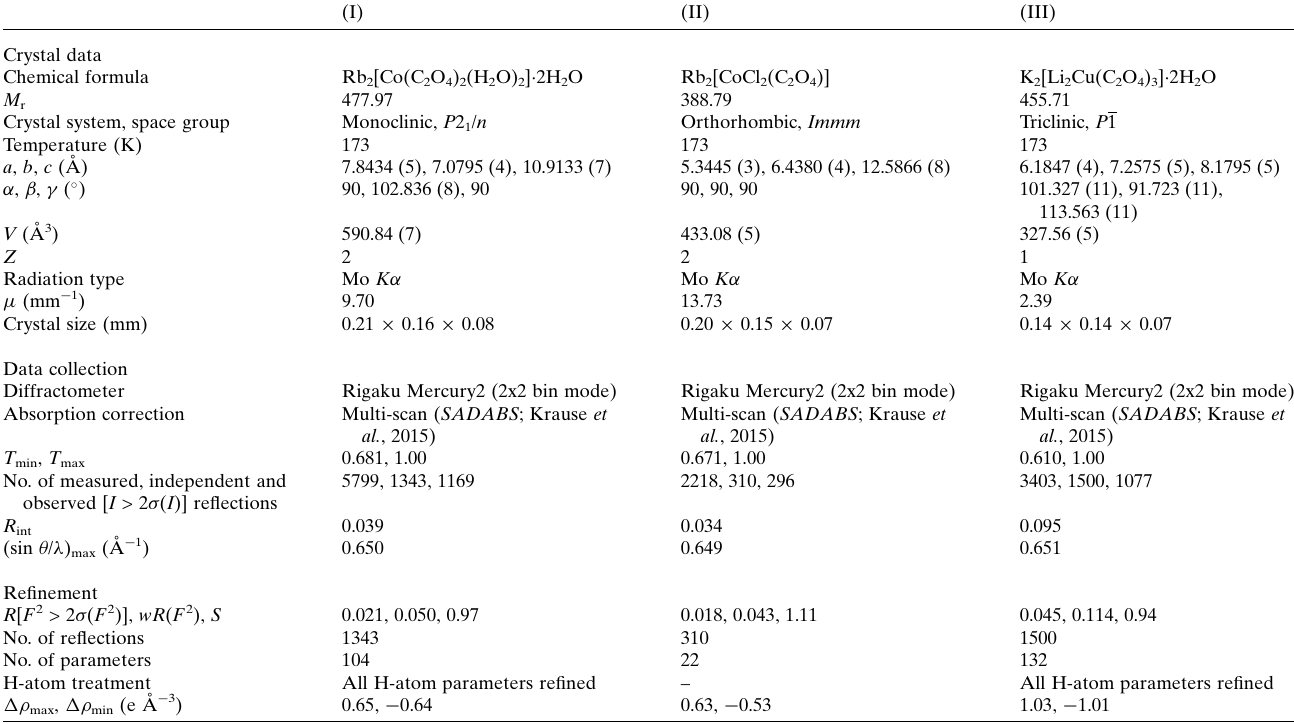
Table 2 Experimental details.